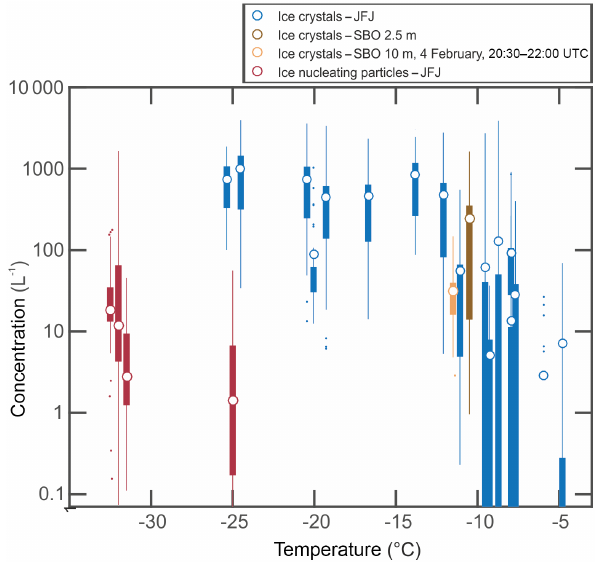
Figure 18. Ice crystal number concentrations (ICNCs; orange and brown) measured on the elevator at the SBO are compared to the ICNCs (blue) and ice nucleating particle (INP) concentrations (red) measured at the High Altitude Research Station, Jungfraujoch (JFJ). The ICNCs at the JFJ were measured with HOLIMO II during the winter 2012 and 2013 (Lohmann et al., 2016). Each box represents a cloud case. The INP concentrations were measured with the Hor- izontal Ice Nucleation Chamber (Lacher et al., 2017, and additional measurements) at a relative humidity with respect to water (RH w ) of 103–104%. The three boxes on the left were taken during (from the left) Sahara dust events, summer seasons and winter seasons at a temperature of − 31 ◦ C, but shifted slightly to visualize them. The measurements at − 25 ◦ C were taken during a summer season. The left and right edges of each box represent the 25th and 75th per- centiles, the circle is the mean value and the small dots are